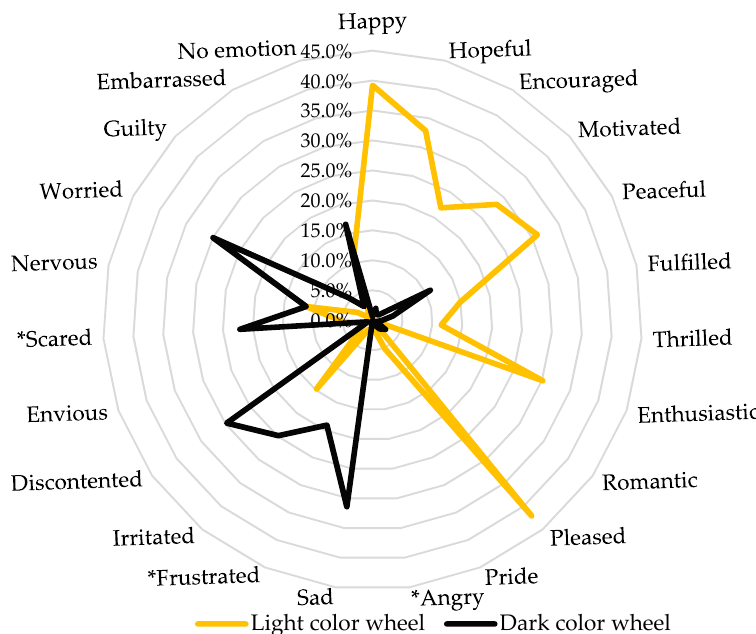
Figure 7. Percentage frequency of an emotional reaction given to each color wheel. Asterisks indicate significance results. n = 487.